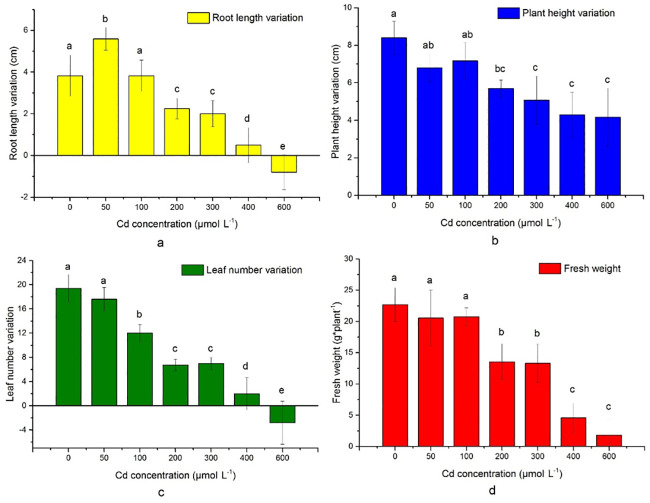
Effects on different Cd treatments on physical parameters of S. portulacastrum (Different letters in different treatments suggest significant difference (P<0.05) between treatments according to ANOVA and Turkey test).